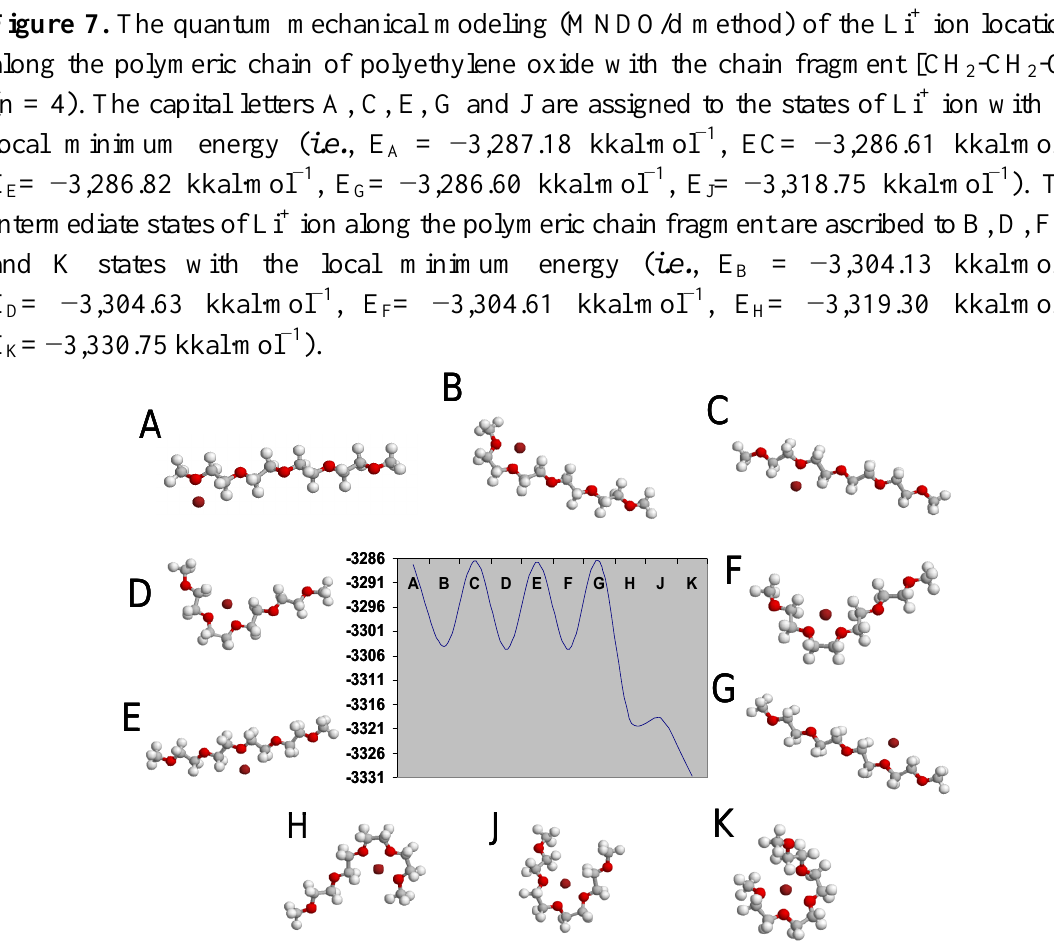
Figure 8. The quantum mechanical calculation of the Li + ion local energies with the non-operating transitions L and M (E which exist between the intermediate states (B, etc.